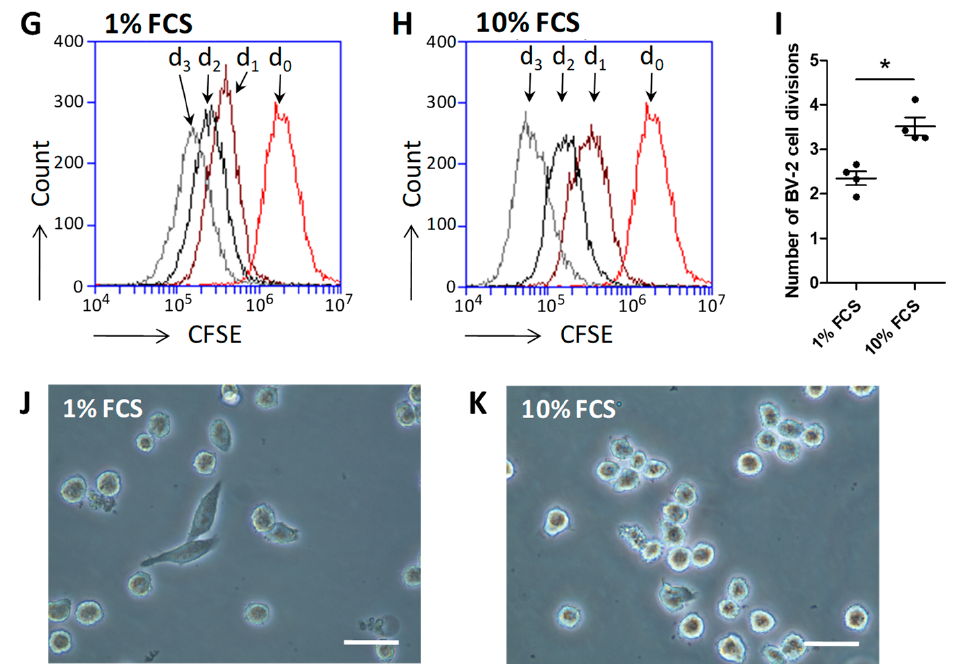
Figure 1. Variations of serum concentrations affect the viability and differentiation of BV-2 cells. ( A ) The viability of BV-2 cells grown in presence of different serum concentrations was assessed by a MTT assay and corroborated ( B ) with a 7-AAD viability staining measured by flow cytometry. ( C , D ) The supernatant of BV-2 grown in a low concentration of serum (1% Fetal Calf Serum (FCS)) does not modify the survival of 158N oligodendrocyte cell line, whereas ( E , F ) the supernatant of BV-2 grown in a high concentration of serum (10% FCS) reduced significantly the survival of 158N